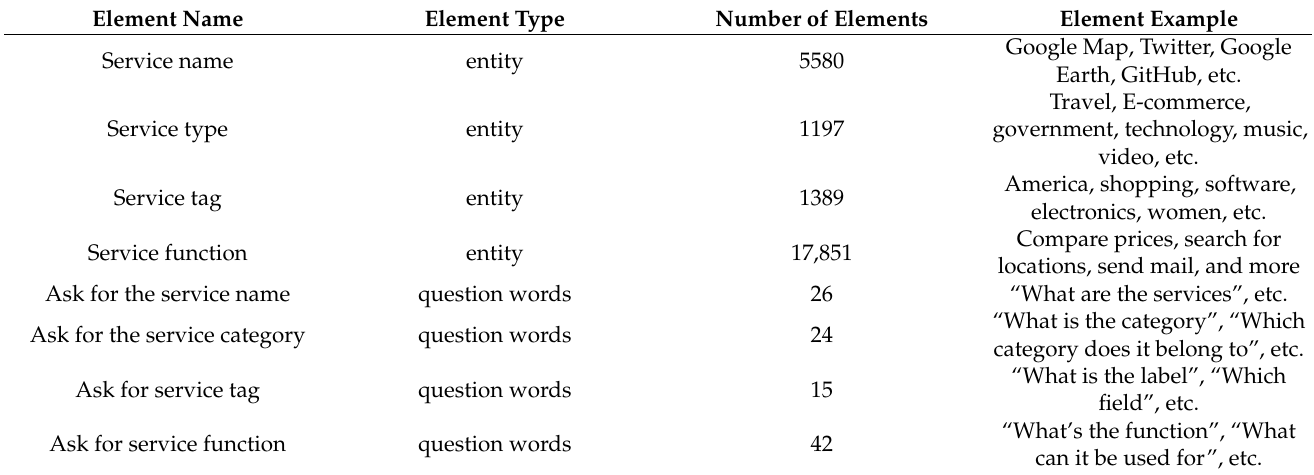
Table 1. Service